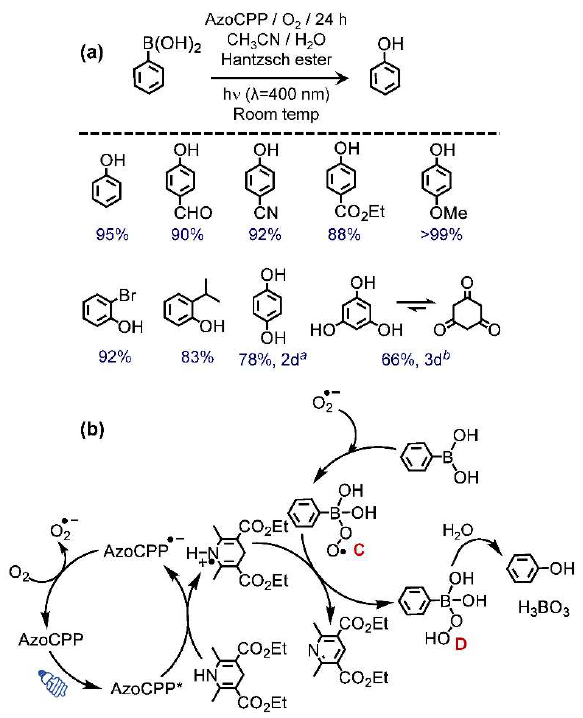
Figure 5. ( a ) Photocatalytic dehydroxylation of aryl boronic acids to alcohols with corresponding substrate scope and product yields (GC), a 2 times more HE was used, b 3 times more HE was used; ( b ) proposed mechanism for the reaction.